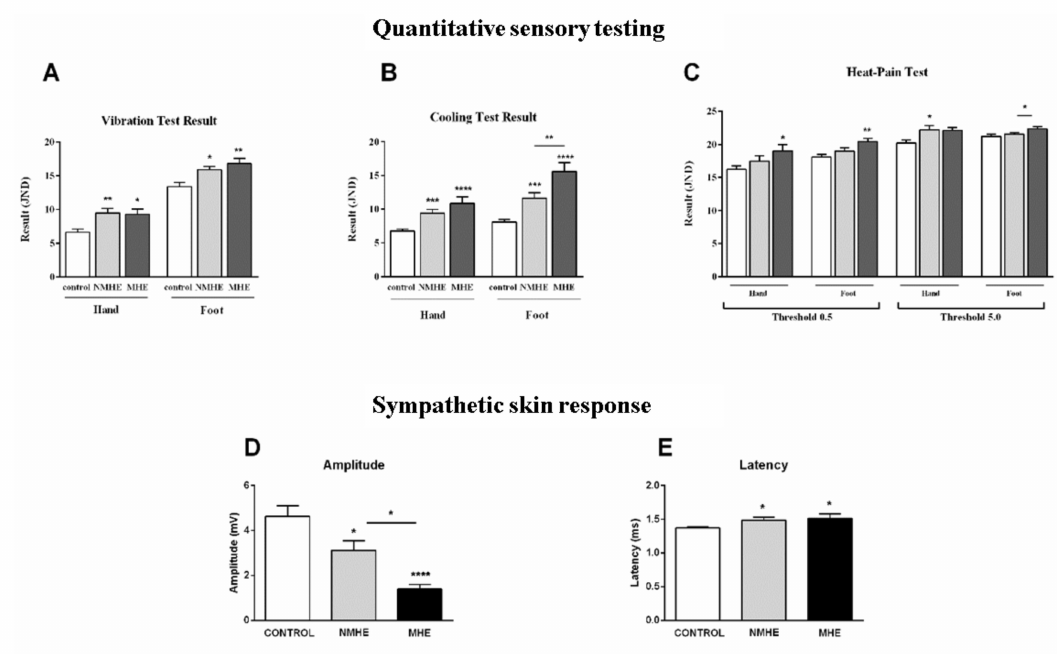
Figure 2. MHE patients with normal sural nerve amplitude show alterations in thermal sensitivity and sympathetic skin response compared to NMHE patients and controls. ( A – C ) Quantitative sensory test (QST) parameters: ( A ) Vibration detection threshold, ( B ) Cooling detection threshold, and ( C ) Heat Pain detection threshold, at 0.5 and 5.0 thresholds. ( D – E ) Sympathetic skin response: ( D ) Amplitude, ( E ) Latency. JND: just noticeable differences; MHE, NMHE: patients with and without minimal hepatic encephalopathy, respectively. Results are the mean ± SEM. * p < 0.05; ** p < 0.01; *** p < 0.001; **** p <